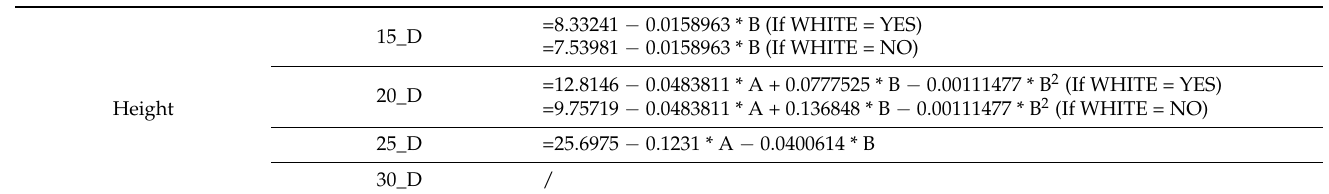
Table 8. Equations of the statistically reliable mathematical models calculated in terms of actual